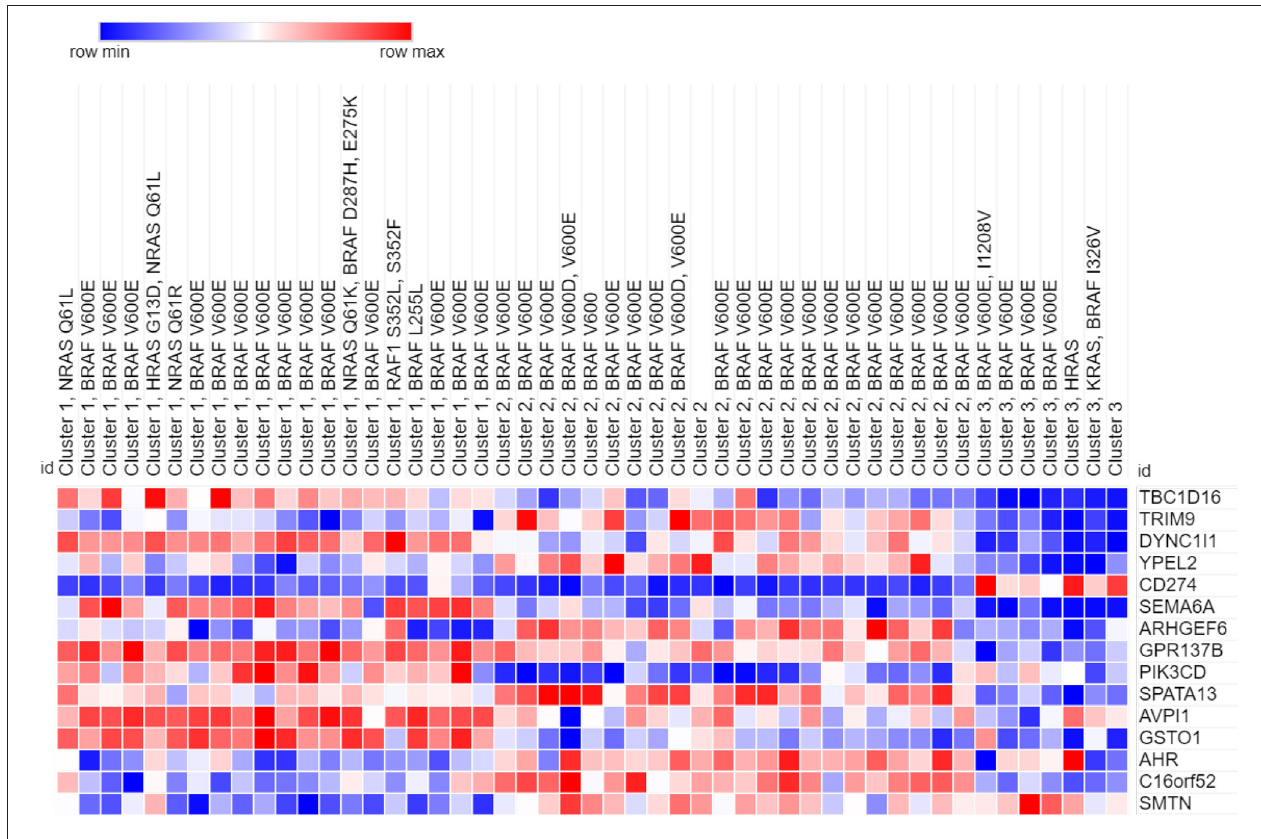
FIGURE 5 | Heatmap of 49 melanoma cell lines with top 15 genes.